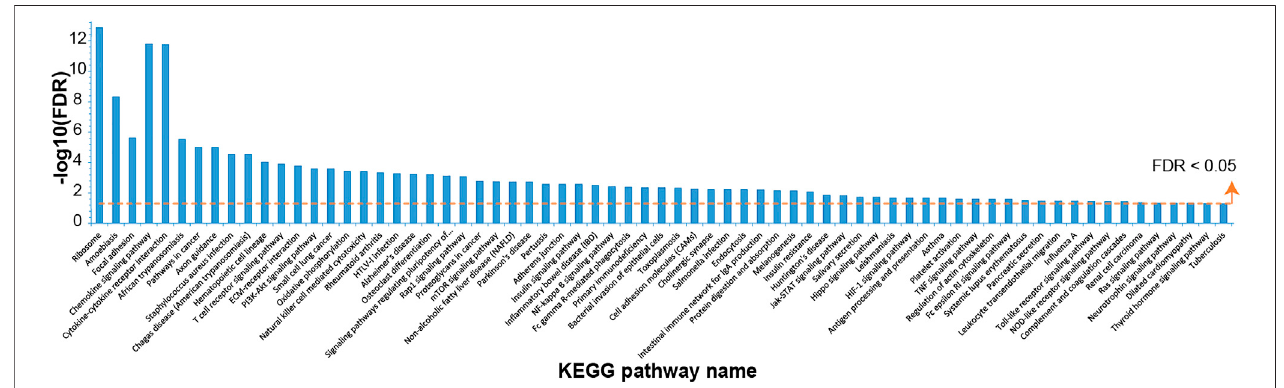
FIGURE 1 | The Kyoto Encyclopedia of Genes and Genomes (KEGG) pathways enriched with dysregulated genes in chronic obstructive pulmonary disease (COPD) rat data compared with control data.